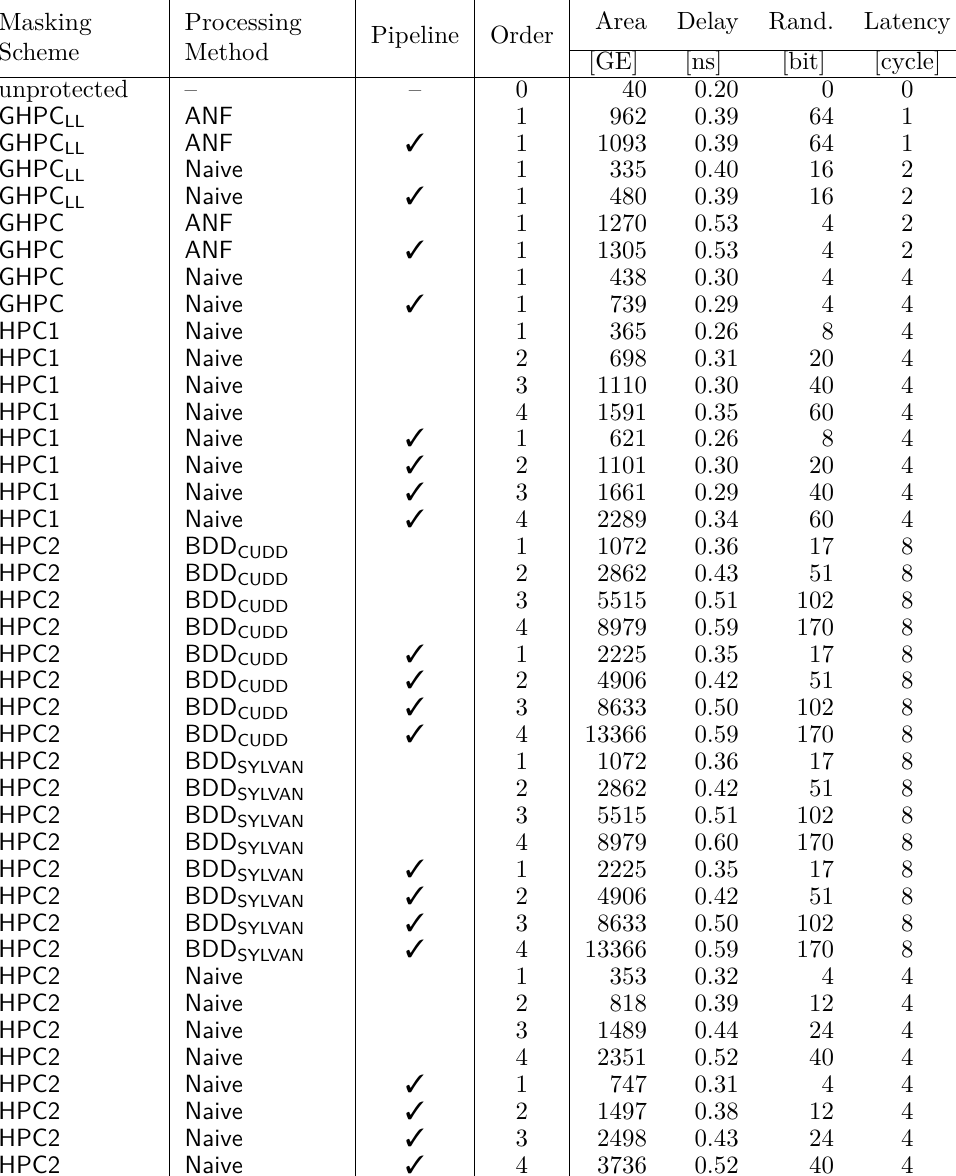
Table 4: Synthesis results, Skinny S-box optimized